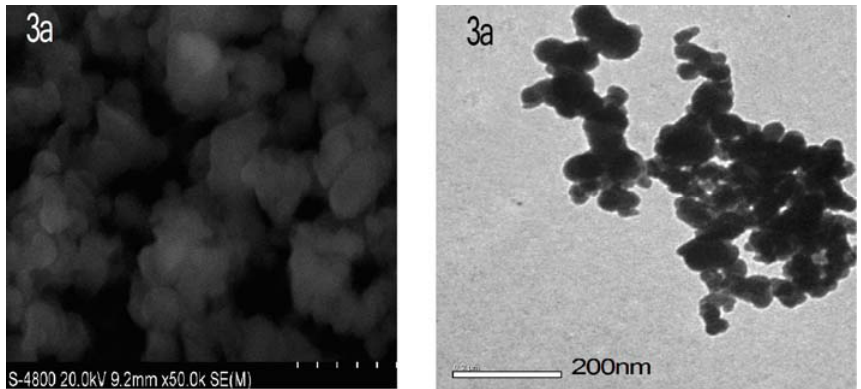
Figure 3. (a) SEM image of aminophosphonates zirconium 3a and (b) TEM image of aminophosphonates zirconium